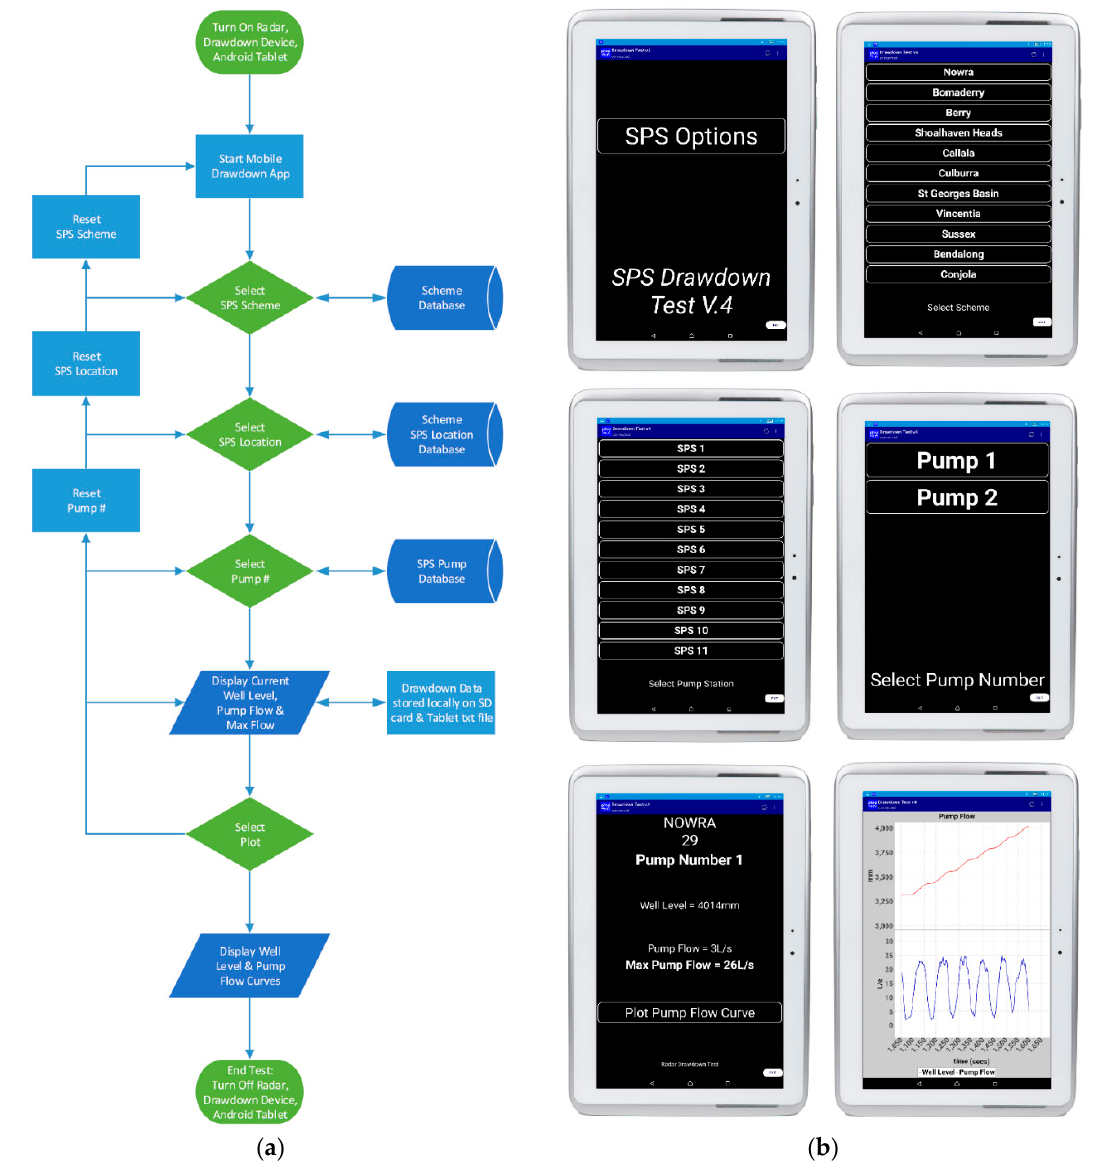
Figure 10. SPUDD (a) Operational flow chart, and (b) Mobile application screens. Figure 10. SPUDD ( a ) Operational flow chart, and ( b ) Mobile application